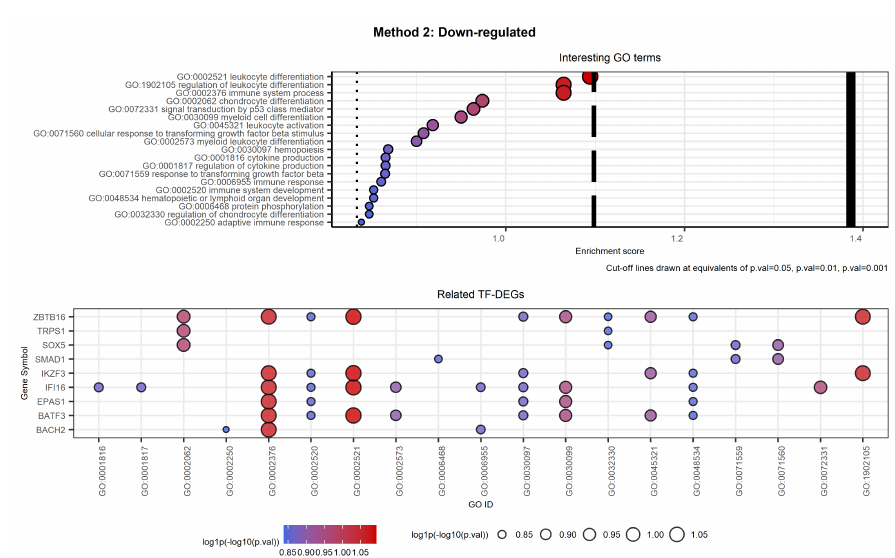
Figure 15. Selected GO terms and related TF-DEGs. The first plot shows selected GO terms on the y -axis and the respective log1p( − log10( p -value)) as the Enrichment score on the x -axis. The second plot shows TF-DEGs on the y -axis and the related GO terms on the x -axis. In both plots, colour and size of the bubbles depend on the Enrichment score. We note that both genes MECP2 and NR2E1 are involved in the same process, while RARG is identified as strictly CML-related. We note that almost all genes are associated with the most significant GO labels involving leukocyte differentiation.